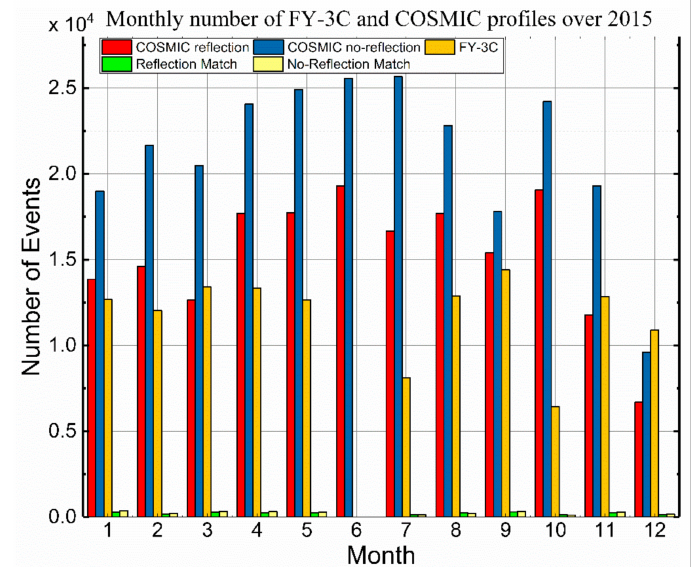
Figure 2. Monthly number of COSMIC occultations with reflection, no-reflection, FY-3C occultations and matched occultations from January to December